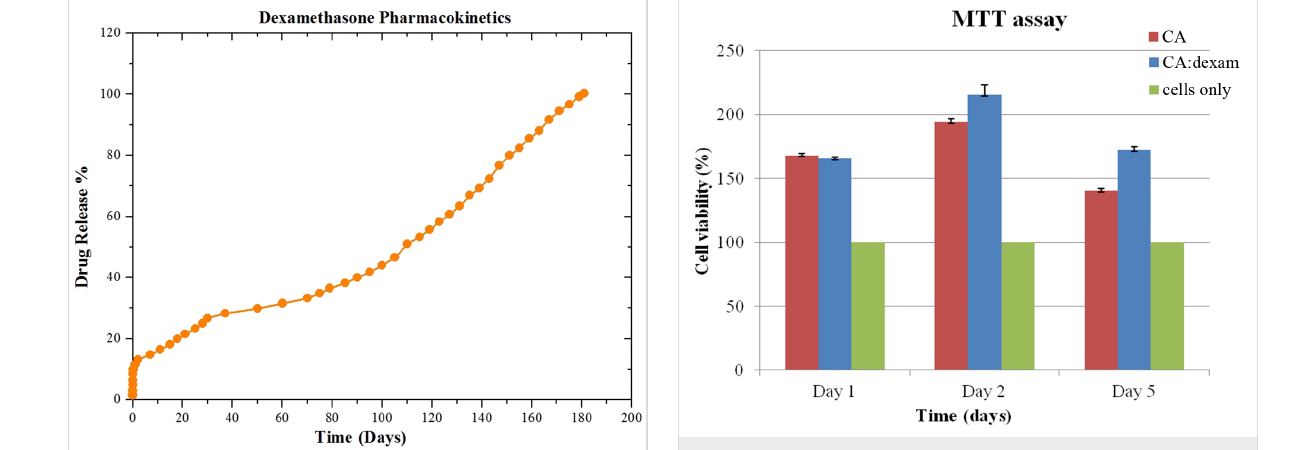
almost covered the entire surface of the scaffolds indicating that the scaffolds exhibited good cytocompatibility.